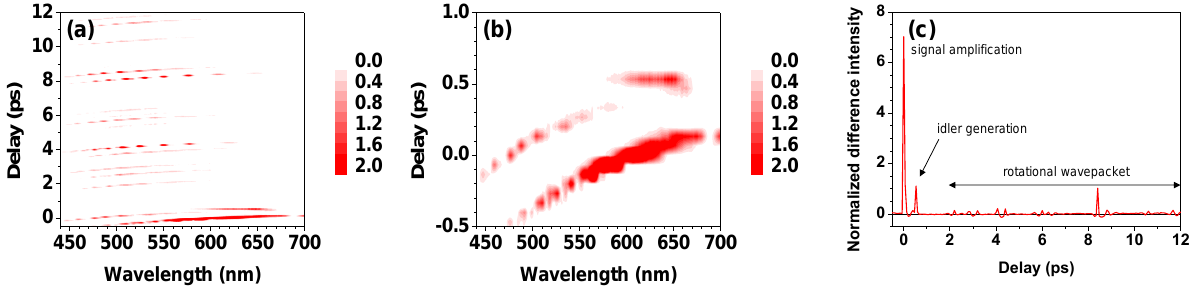
Figure 5. ( a ) The two-dimensional difference spectra of the signal pulse. ( b ) An expanded view of ( a ). ( c ) Delay dependence of the difference intensity at 610 nm in ( a